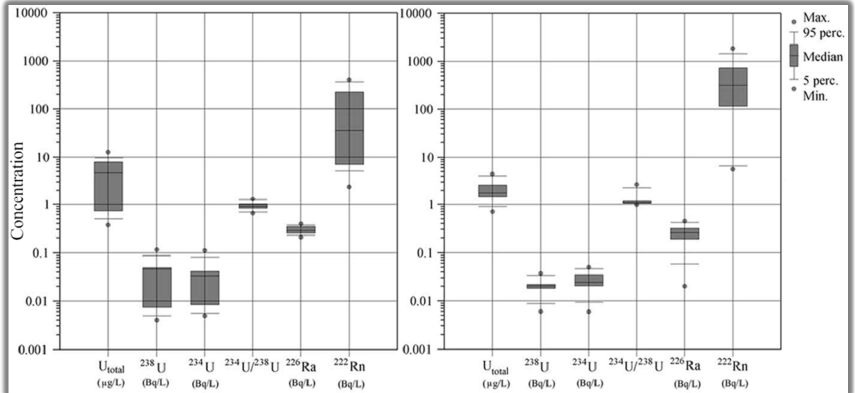
Figure 5. Concentration for groundwater radionuclides from Paranhos and Salgueiros spring galleries, in the granitic gutter pipe, group I ( left ) and the granitic rock fractures, group II ( right